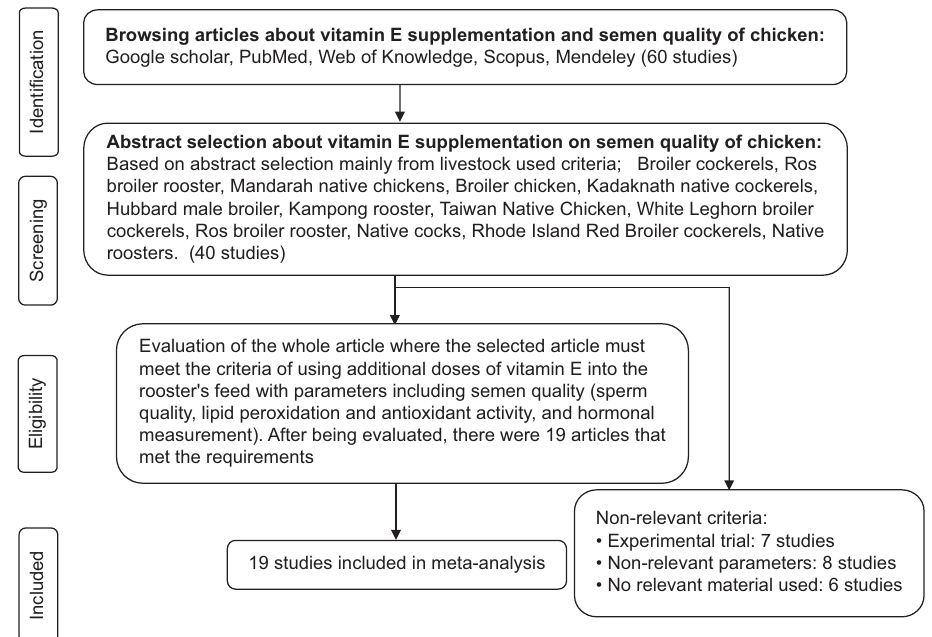
Figure-1: The selection of articles and evaluation process using PRISMA method. PRISMA=Preferred Reporting Items for Systematic Reviews and Meta-Analyses. Table-2: The effects of dosage vitamin E on semen quality of chicken.